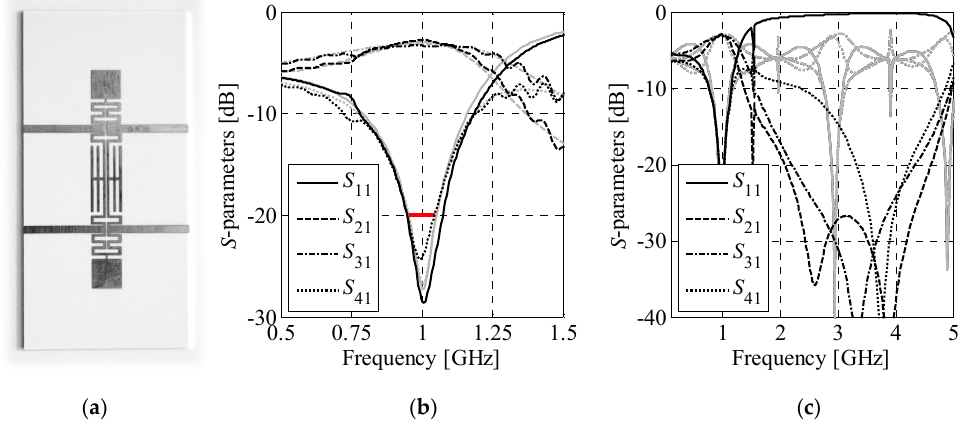
Figure 15. Branch-line coupler B A (3,1) of Section 4.3: ( a ) photograph of the manufactured circuit prototype, ( b ) comparison of simulated (gray) and measured (black) responses, and ( c ) comparison of the broadband frequency characteristics (black) against the responses of conventional BLC (gray).